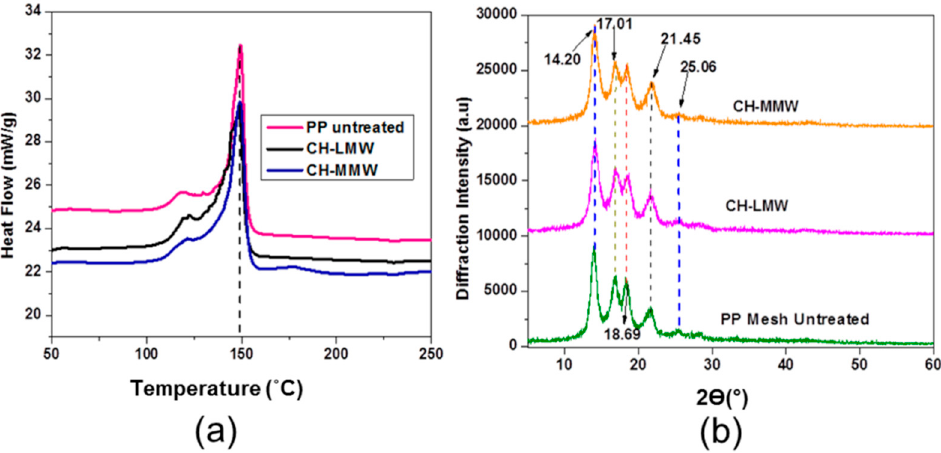
Figure 6. Thermal and structural properties: ( a ) differential scanning calorimetry (DSC) analysis and ( b ) X-ray diffraction (XRD) patterns of treated and untreated PP meshes.